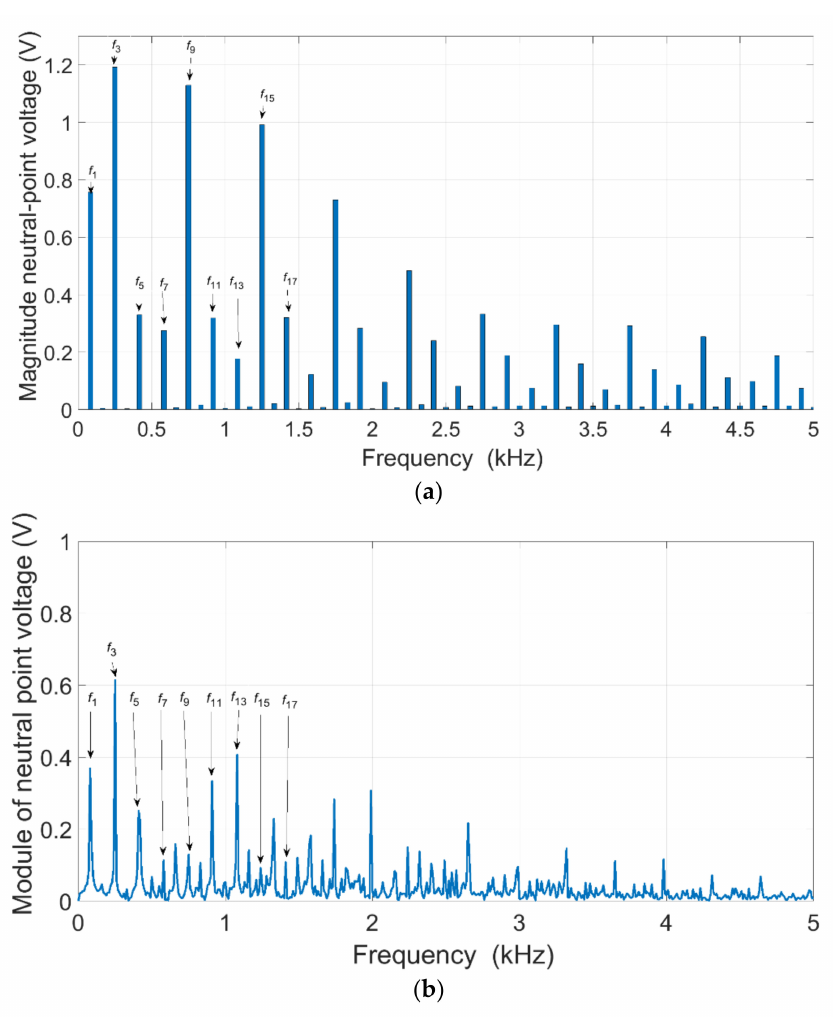
Figure 17. Y (cid:52) configurations—FFT of neutral voltage—SC1: ( a ) numerical calculations, ( b )